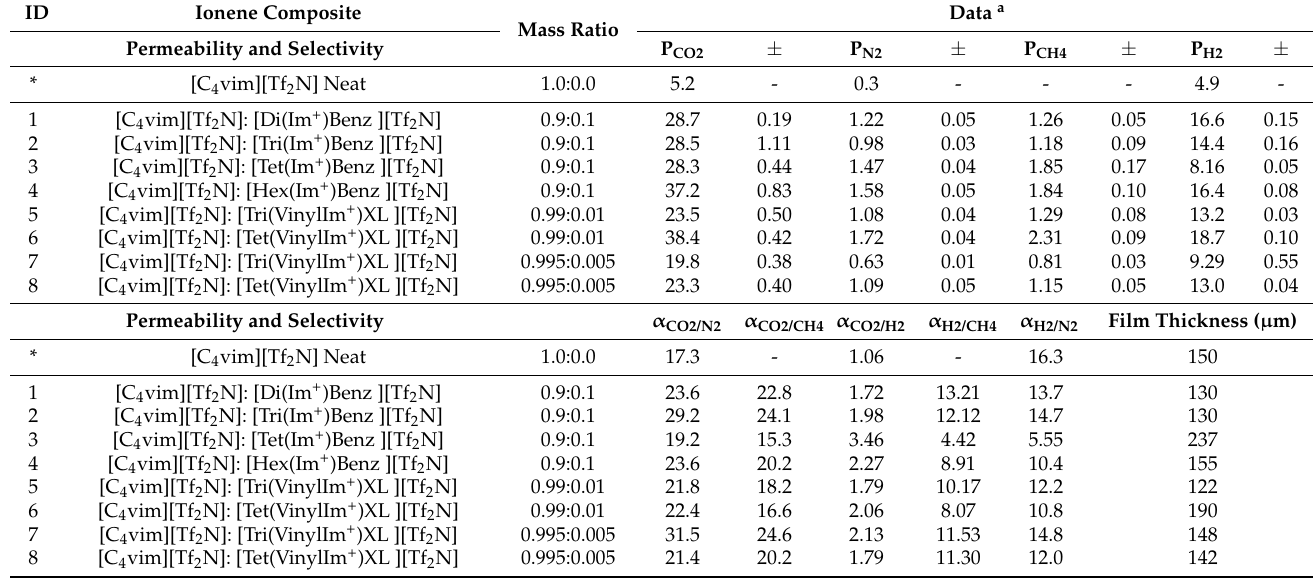
Table 2. Pure gas permeability and selectivity data for each PIL